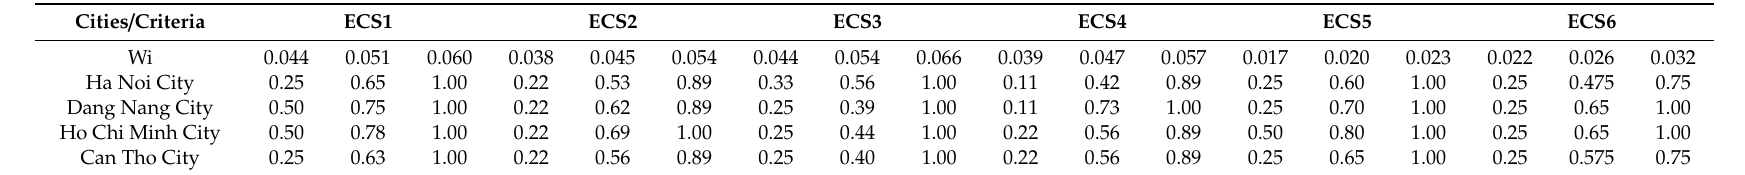
Table 12. Weights and normalized fuzzy decision matrix.